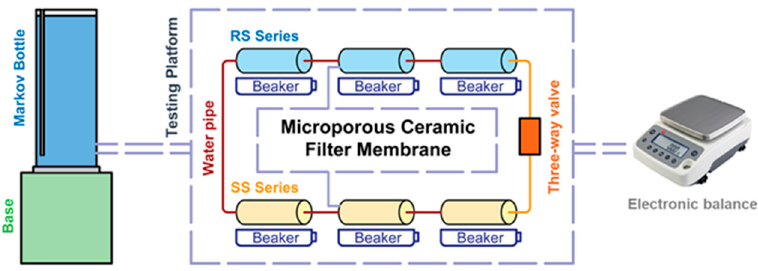
Figure 3. Hydraulic performance test device.